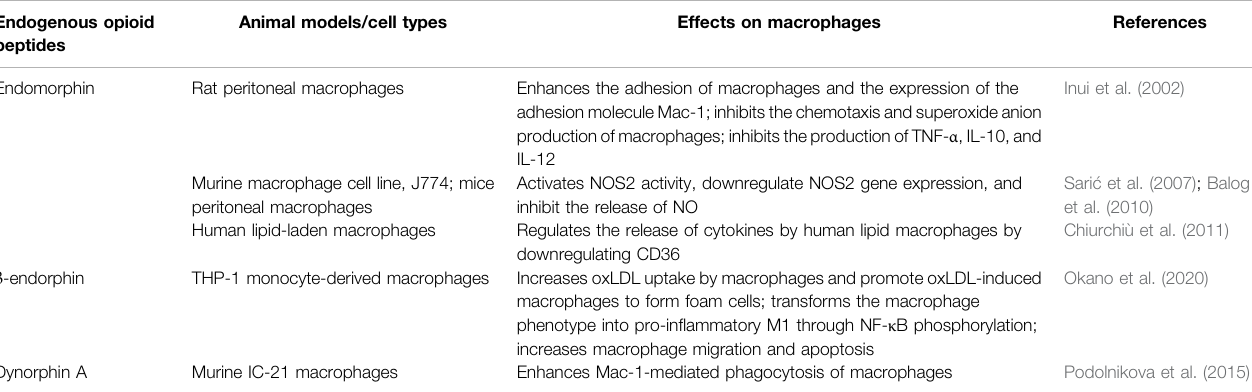
TABLE 5 | The effects of endogenous opioid peptides on macrophage ’ s